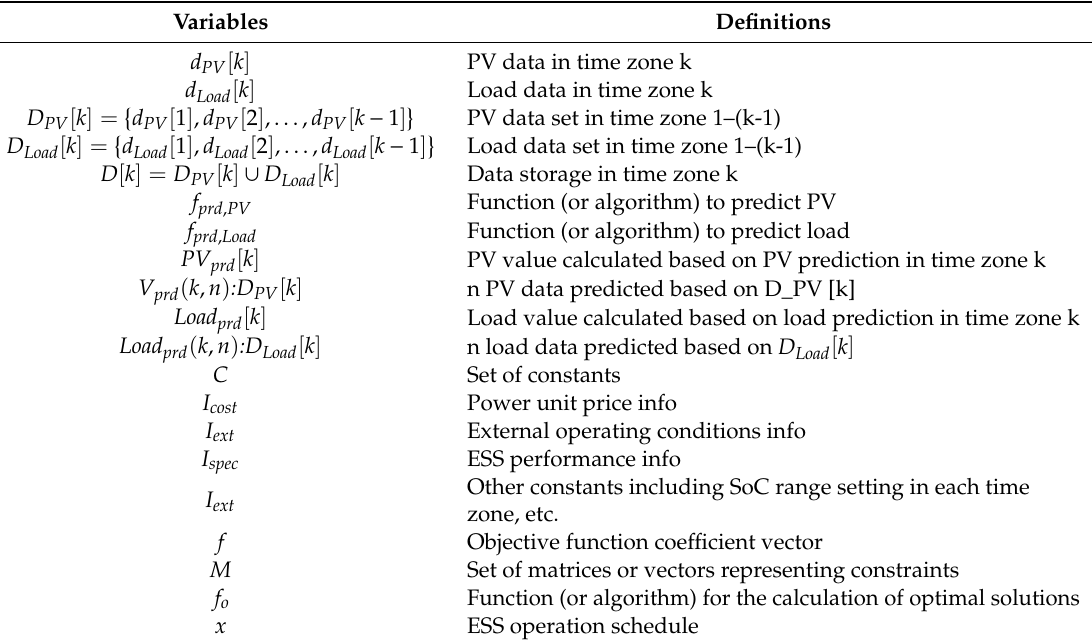
Table 2. Definitions of Variables